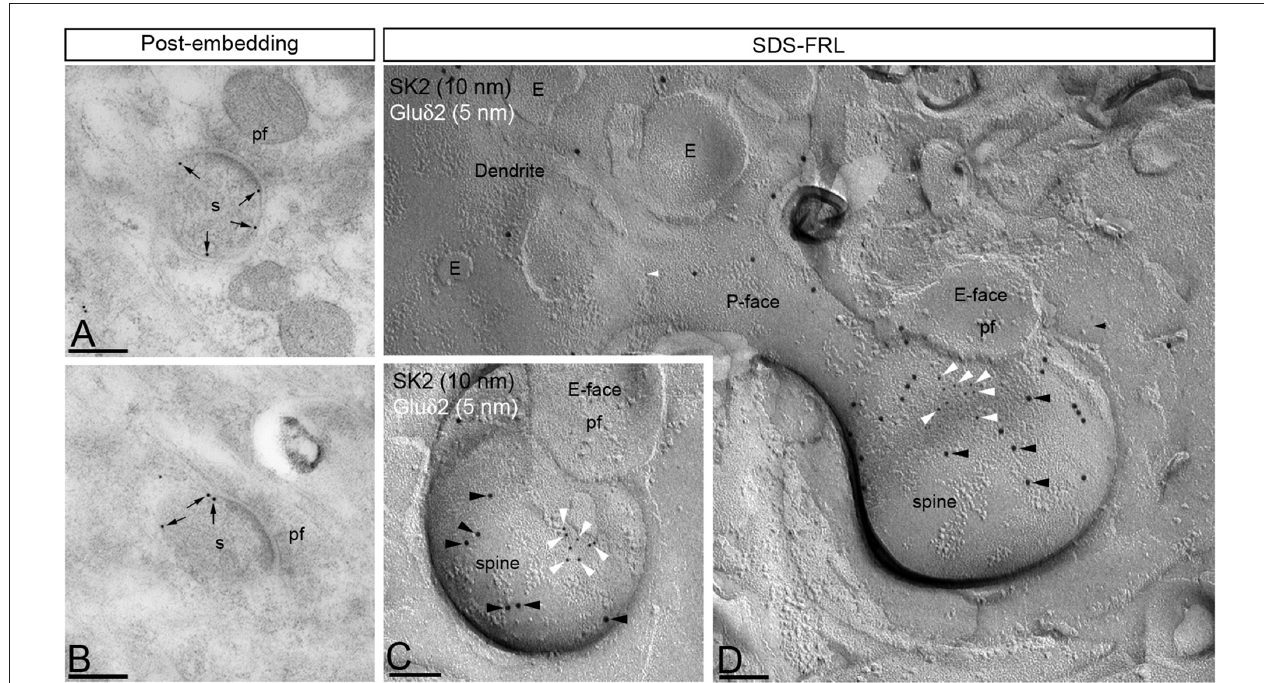
FIGURE 3 | SK2 channels are excluded from the postsynaptic membrane specializations in PC spines. Electron micrographs showing immunoparticles for SK2 in the molecular layer of the cerebellar cortex, as detected using the post-embedding immunogold (panels A,B ) and the SDS-FRL (panels C,D ) techniques in the adult mice. (A,B) Using the post-embedding immunogold method, immunoparticles for SK2 were always detected outside the synaptic specialization and only detected both at perisynaptic and extrasynaptic sites (arrows) of PC spines (s) establishing excitatory synapses with parallel fiber terminals (pf). (C,D) Using the highly sensitive SDS-FRL technique, immunoparticles for SK2 (10 nm, black arrowheads) did not co-cluster with particles for Glu δ 2 that is expressed selectively at PF-PC synapses (5 nm, white arrowheads), demonstrating the absence of SK2 from the PSD of excitatory synapses between PC spines and PFs. Scale bars: (A,B) 0.2 µ m; (C,D) 0.1 µ